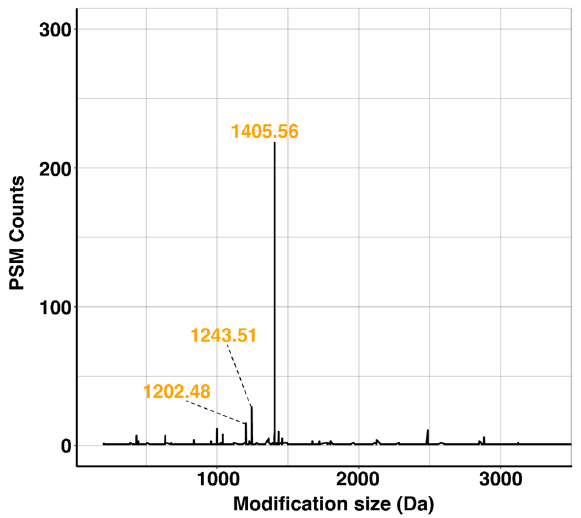
Figure 4. Open searching results (data files searched using MSfragger (v15)) of C. hepaticus HV10 T . Open database searching revealed the presence of a 1405.56 Da modification, consistent with the mass expected of C. jejuni heptasaccharide glycan. In addition, masses of 1243.51 and 1202.48 Da, corresponding to the loss of Hex and HexNAc from the heptasaccharide, were